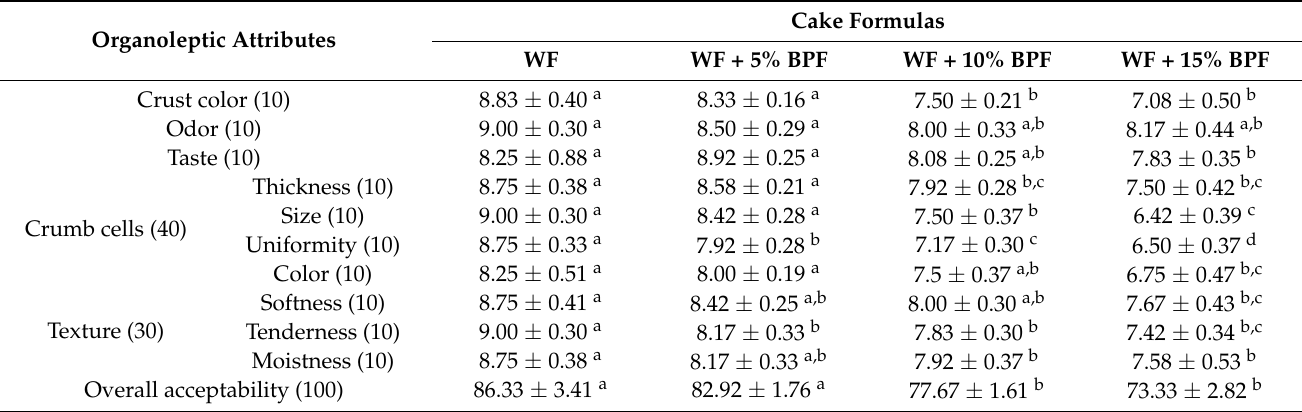
Table 8. Organoleptic properties of WF and substituted WF with BPF ( A. digitate